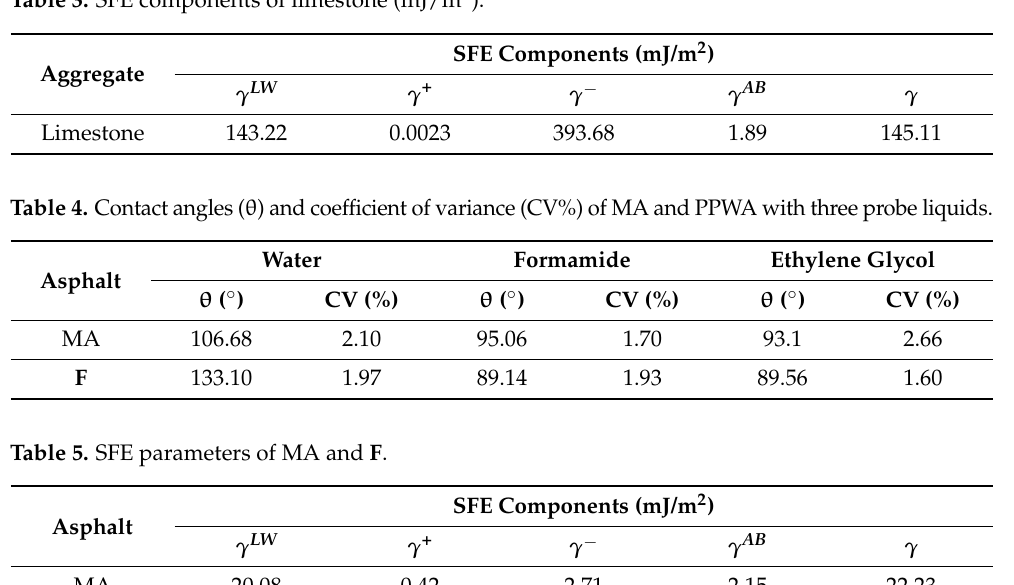
Table 3. SFE components of limestone (mJ/m 2 ).